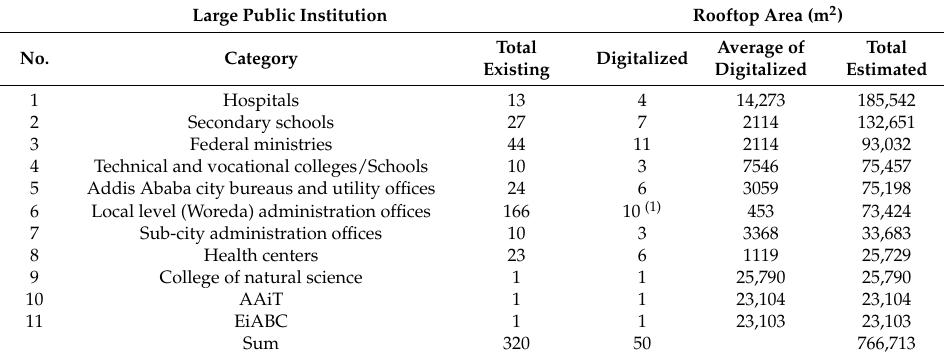
Figure 1. Distribution of the 588 digitalized rooftops used in this study to represent large public institutions in Addis Ababa. Table 1. The categories of large public institutions and the corresponding digitized rooftop areas.